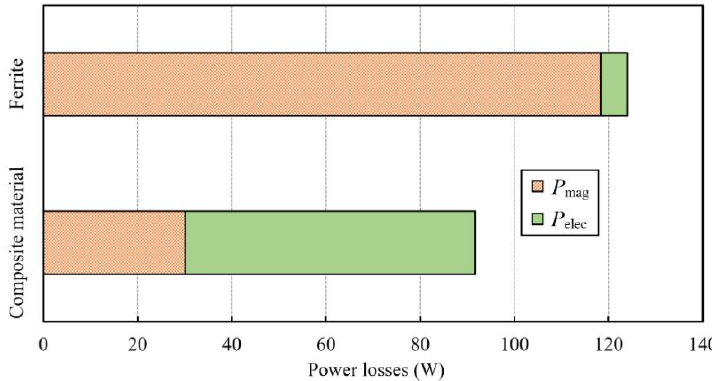
Figure 9. Comparison of power losses of different shields at 2 KW.